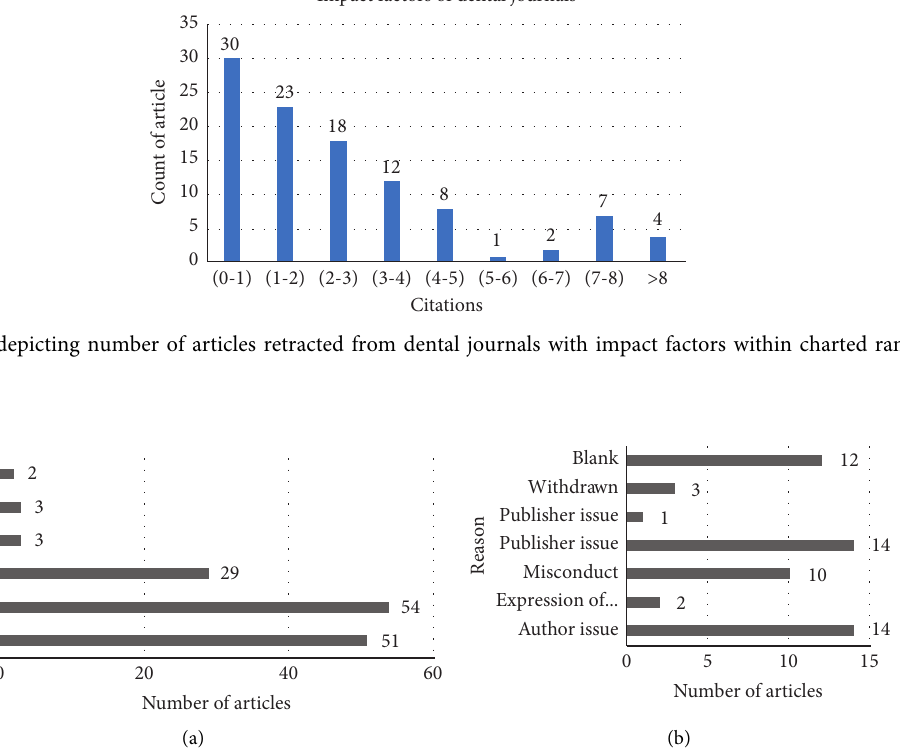
Figure 5: The above plotted graph shows the different enlisted causes of retraction (1–8) as per published COPE7 guidelines on the left and other reasons cited by some journals and their numbers on the